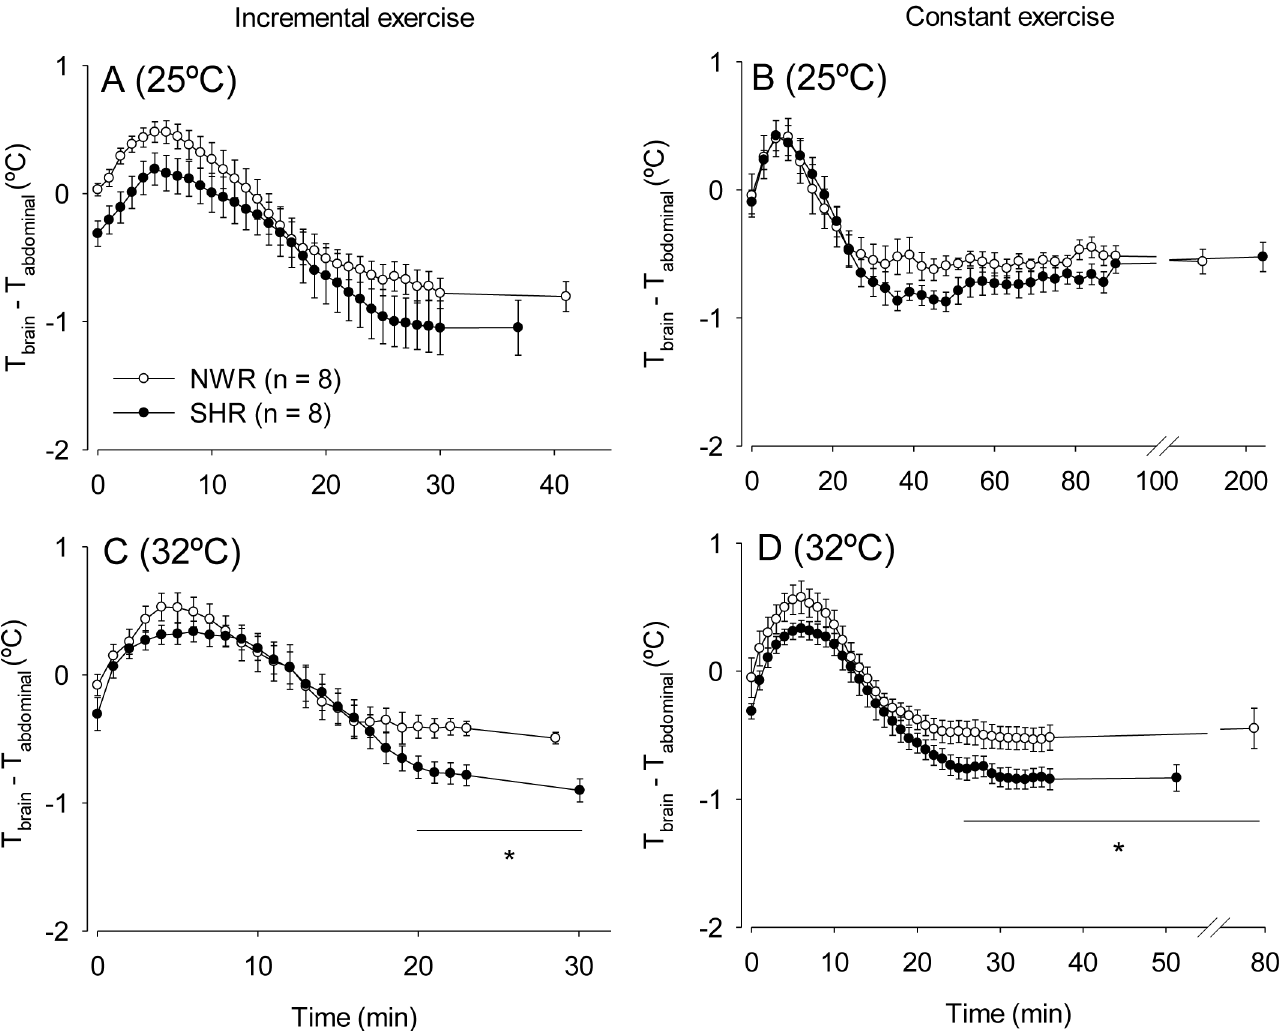
Fig 5. Brain-abdominal temperature differentials during exercise. Brain-abdominal temperature differentials during incremental (panels A and C) or constant (panels B and D) exercise in temperate (A and B) or warm (C and D) environments. Data are expressed as the mean ± S.E.M. * p < 0.05 compared with the NWR group in the same